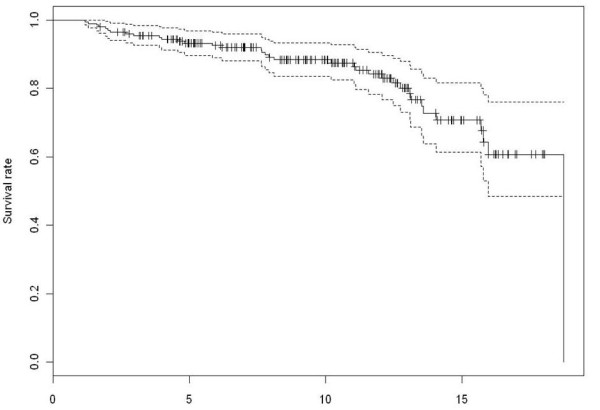
Survival rate analysis after HTO using the Kaplan-Meier method. The conversion to TKA after HTO was set as the endpoint. 93% of patients at 5 years, 84% of patients at 9.6 years and 68% at 15 years after HTO did not require conversion to TKA.